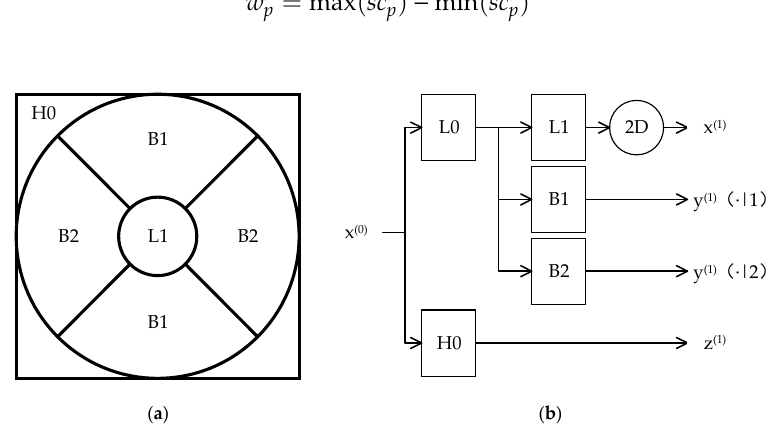
Figure 3. Frequency tiling and the corresponding system diagram. ( a ) Frequency tiling after the first level decomposition with P = 2. ( b ) The corresponding steerable transform. The frequency plane has been decomposed into three parts: a low-pass band, a high-pass band, and two oriented band-pass components. After the Steerable Pyramid (SP) decomposition, the approximation signal x (1) , the high-pass signal z (1) , and the band-pass signal y (1) ( · | p) are obtained. If the orientation parameter p is consistent with the direction of the sea clutter, the corresponding e ffi ciency weight w s is lower compared to the weights of other orientation saliency maps. Given a set p of orientation saliency maps with fixed scale s, we rank them in descending order according to (cid:48) s their weights and then preserve the first three saliency maps denoted as sc for subsequent p , p = 1,2,3 segmentation and region extraction. The remaining saliency maps are marked with red